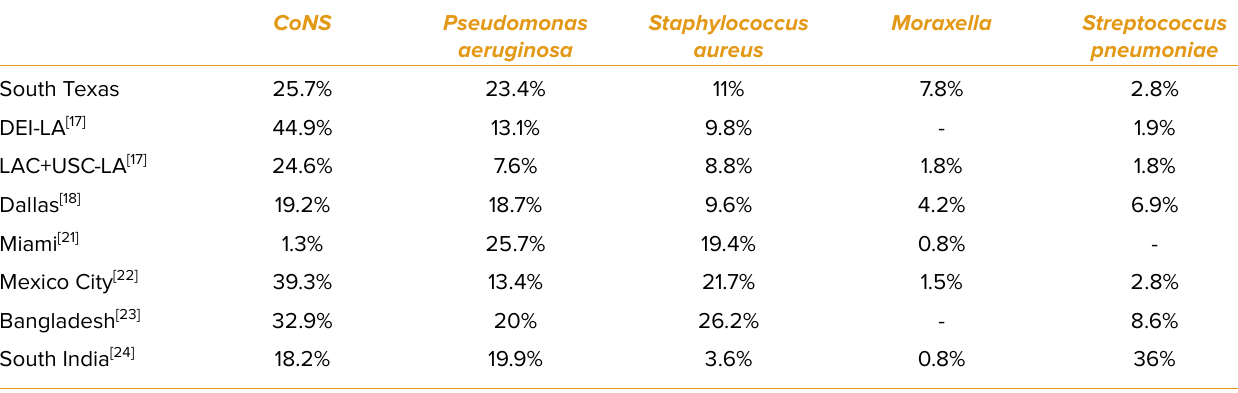
Table 6. Percentage of bacterial isolates in South Texas compared with other locations